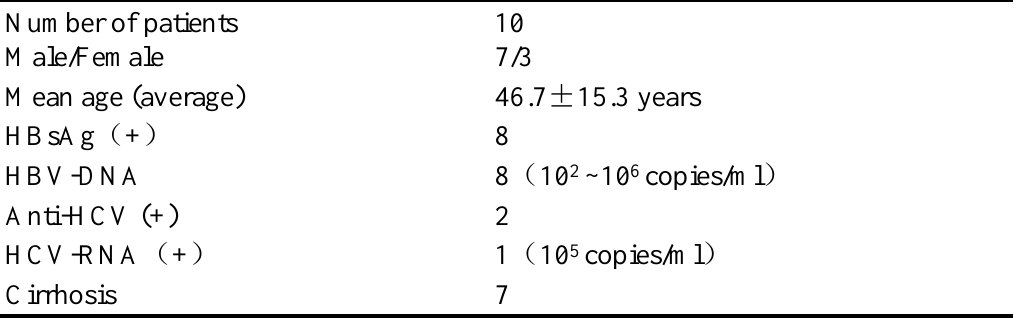
Table 1 . Clinical characteristics of PHC patients enrolled in the